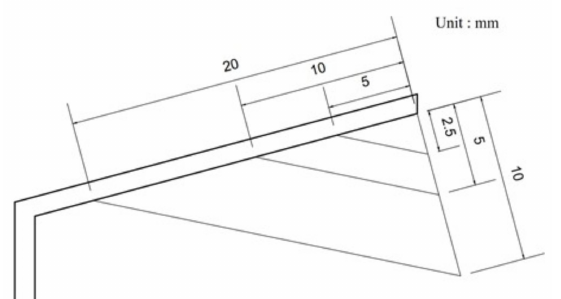
Figure 8. Different actuation dimensions (only the upper wall of the V-groove is